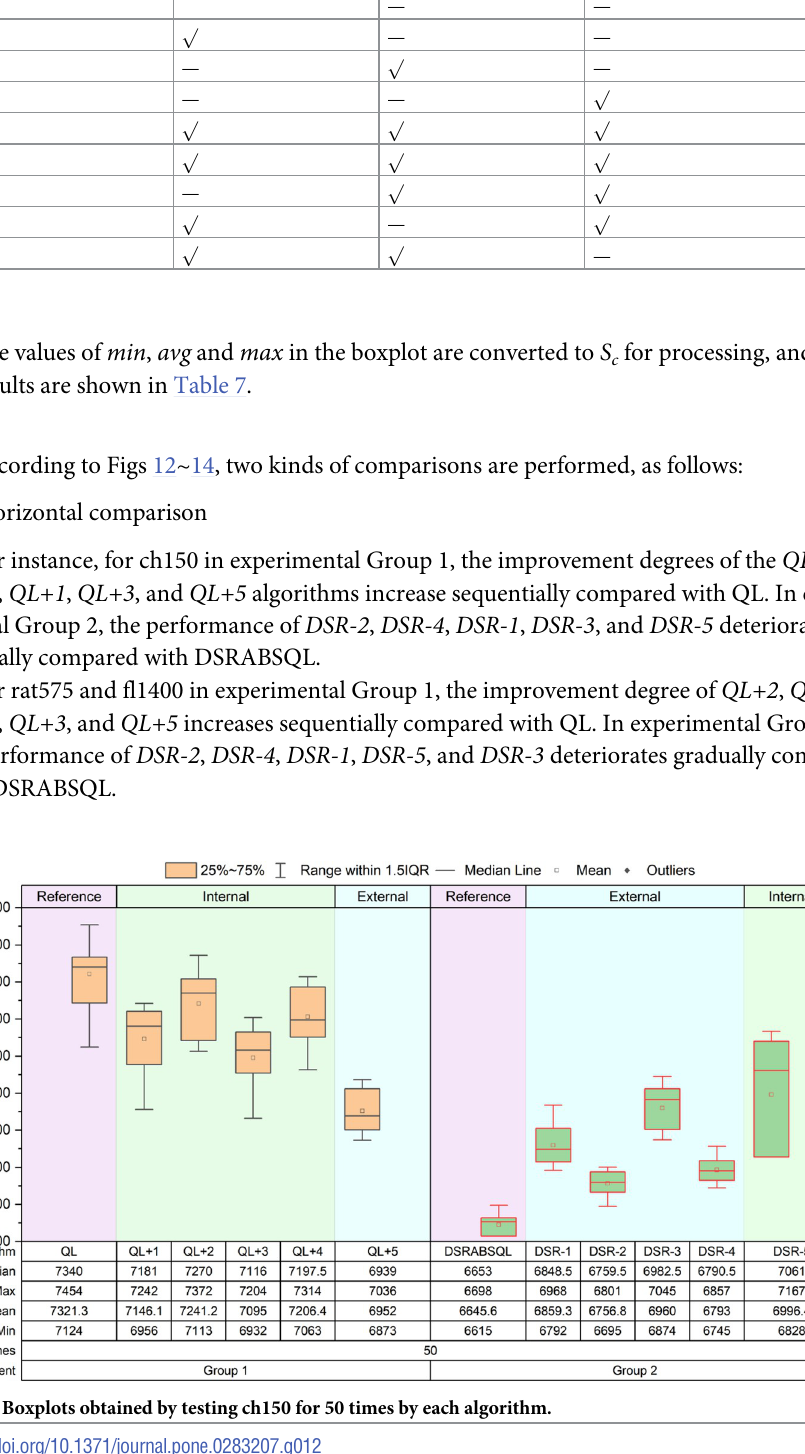
Fig 12. Boxplots obtained by testing ch150 for 50 times by each